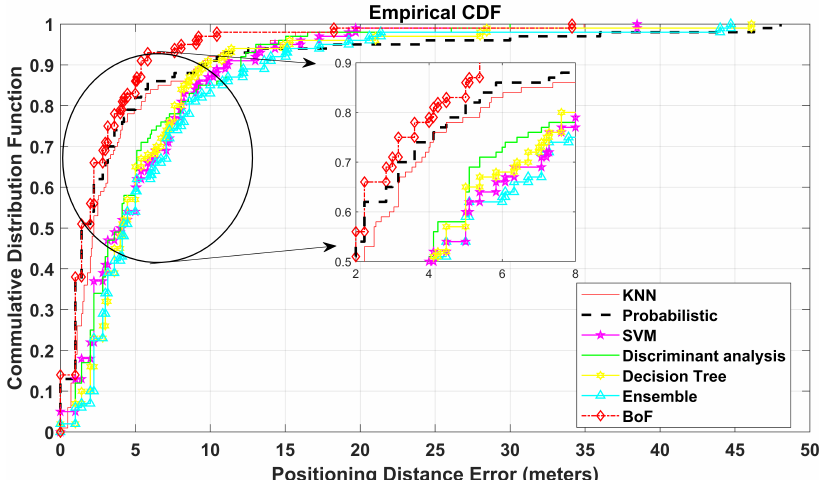
Figure 7. CDF plot for floor with 50 m by 50 m